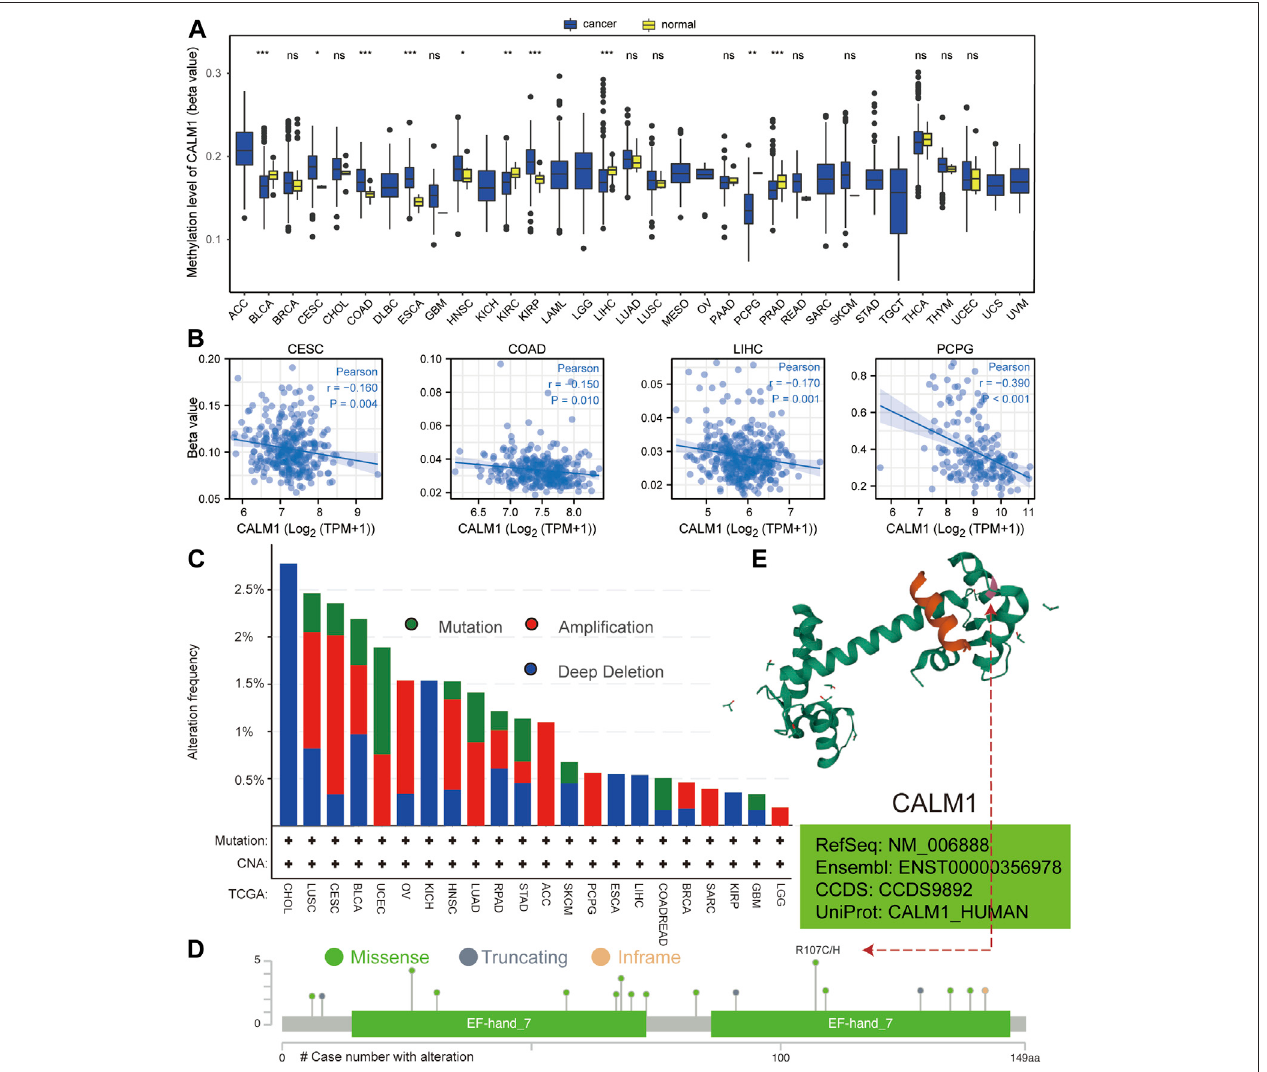
FIGURE 3 | Analysis of DNA methylation and alteration of CALM1 in human cancers. (A) Methylation level of CALM1 in normal and cancer specimens. * P < 0.05; ** P < 0.01; *** P < 0.001; ns, no signi fi cance. (B) Relationship between CALM1 mRNA levels and DNA methylation in cervical and endocervical cancer (CESE), colon adenocarcinoma (COAD), liver hepatocellular carcinoma (LIHC), and pheochromocytoma and paraganglioma (PCPG). (C) Alteration frequency and mutation type of CALM1 isdisplayed. (D) Thetypes,sites,andcasenumbersof CALM1 geneticalterationarepresented. (E) Themutationsitenumbered107isdisplayed inthe3D structure of CALM1